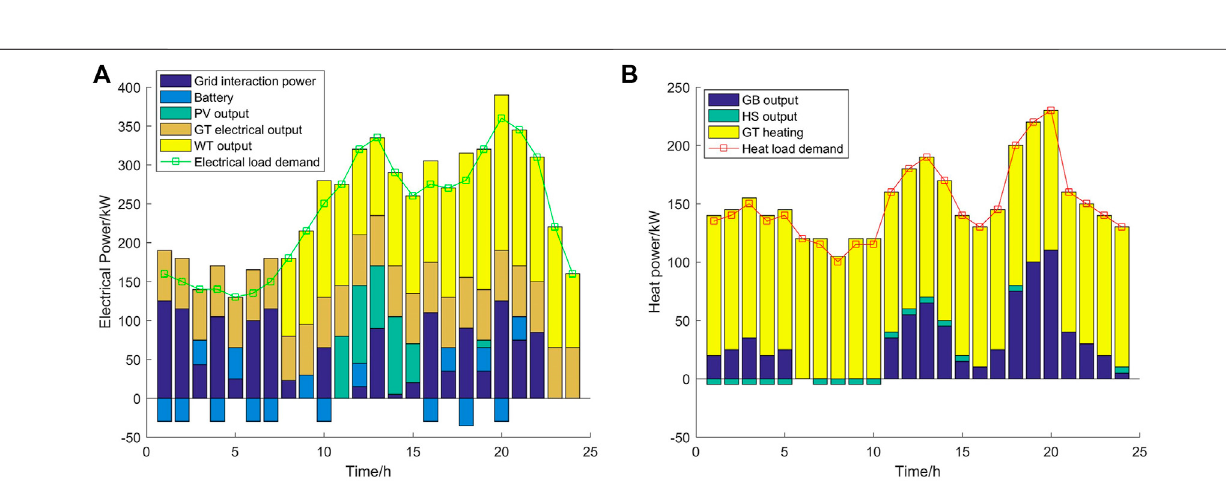
FIGURE 7 | Scenario 2: Balance of electrical load and heat load after optimization. (A) Electrical load and (B) heat load.